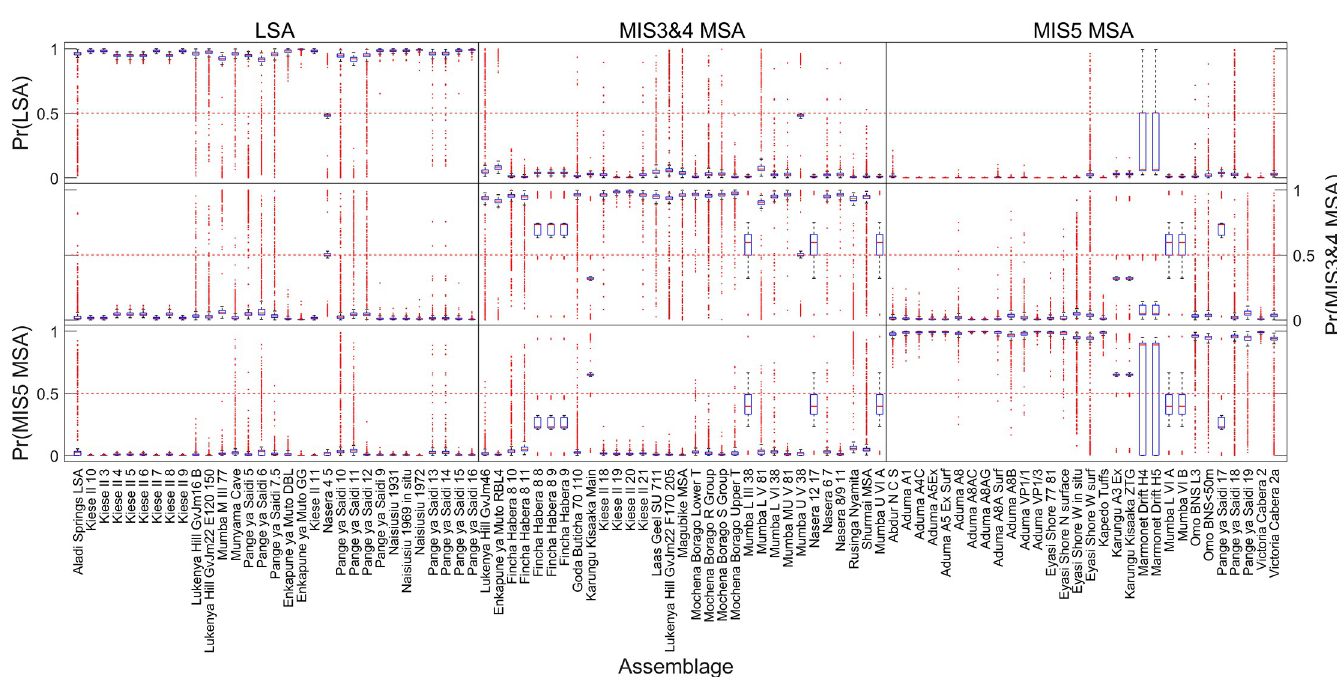
Fig 4. Boxplots of classification probabilities (3-way). Classification probabilities are derived from each of 1,000 neural networks in the 3-way analysis. Red lines show medians, boxes extend to the inter-quartile range, and whiskers show 95% of the distribution. Outliers are shown as red dots. For correct classification, values on the diagonal should be as close to 1 as possible (e.g. values of Pr (LSA) in the LSA section should be as close to 1 as possible, etc.). figure, assemblages incorrectly classified by the weighted median ensemble of networks are shown in red. There was only one incorrectly classified assemblage in the 2-way analysis,